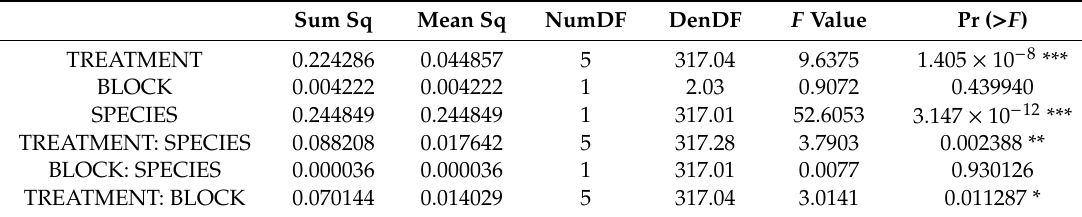
Table A3. Type III Analysis of Variance Table with Satterthwaite’s method.